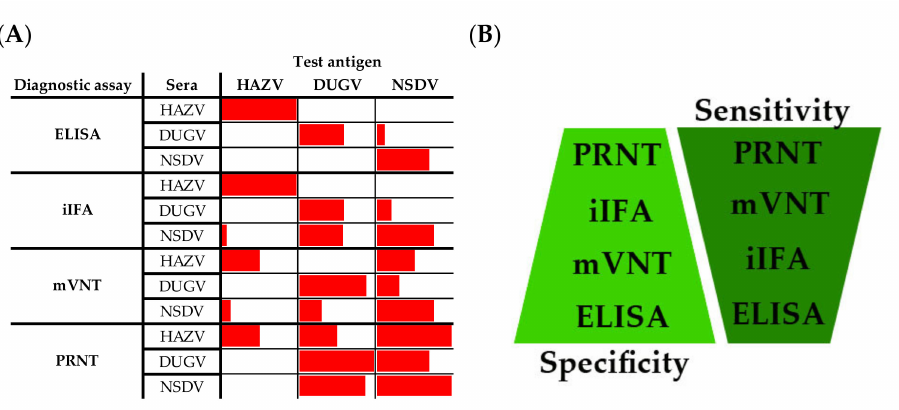
Figure 8. Specificity and sensitivity of HAZV, DUGV, and NSDV assays: Panel ( A ) shows the proportion of positive tested sera within a specific assay in relation to all sera following infections/immunizations with the same challenge virus, which were at least positive in one homologous virus-specific test. Exemplarily, seven sera from the DUGV studies were tested positive in the NSDV PRNT out of ten animals with DUGV antibodies detectable via any DUGV assay, leading to a bar of approx. 70% length. Panel ( B ) visualizes the ranking order of sensitivity and specificity for all diagnostic assays, with highest sensitivity achieved by PRNT and highest specificity by